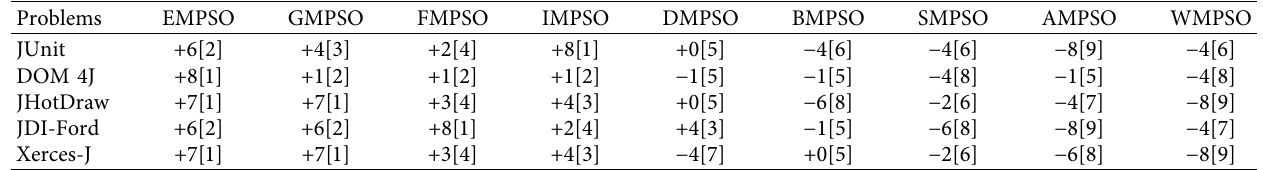
Table 3: Difference [rank] values of each variant in terms of the hypervolume.